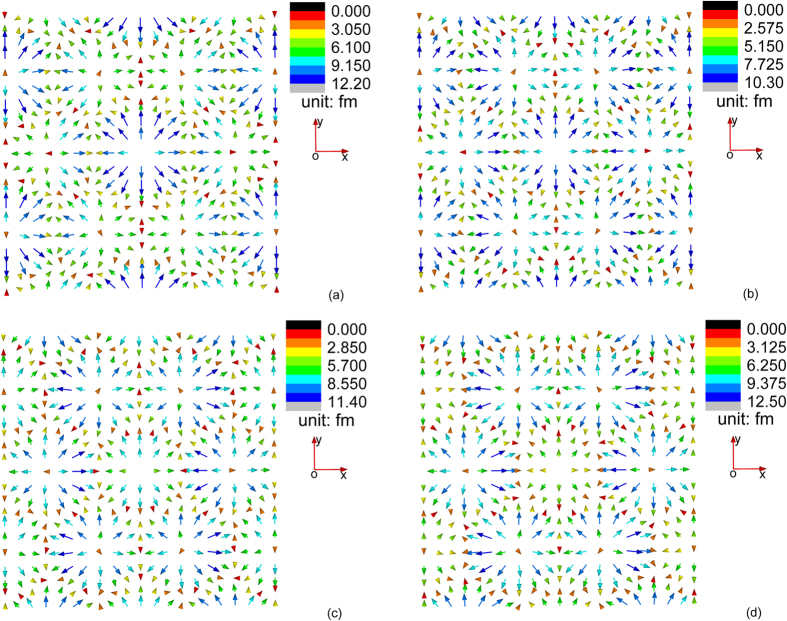
Configuration of uS1 + uS2 + uS3 at temperature 4 K and magnetic field (a) 0.1 T, (b) 0.2 T, (c) 0.3 T, and (d) 0.4 T.